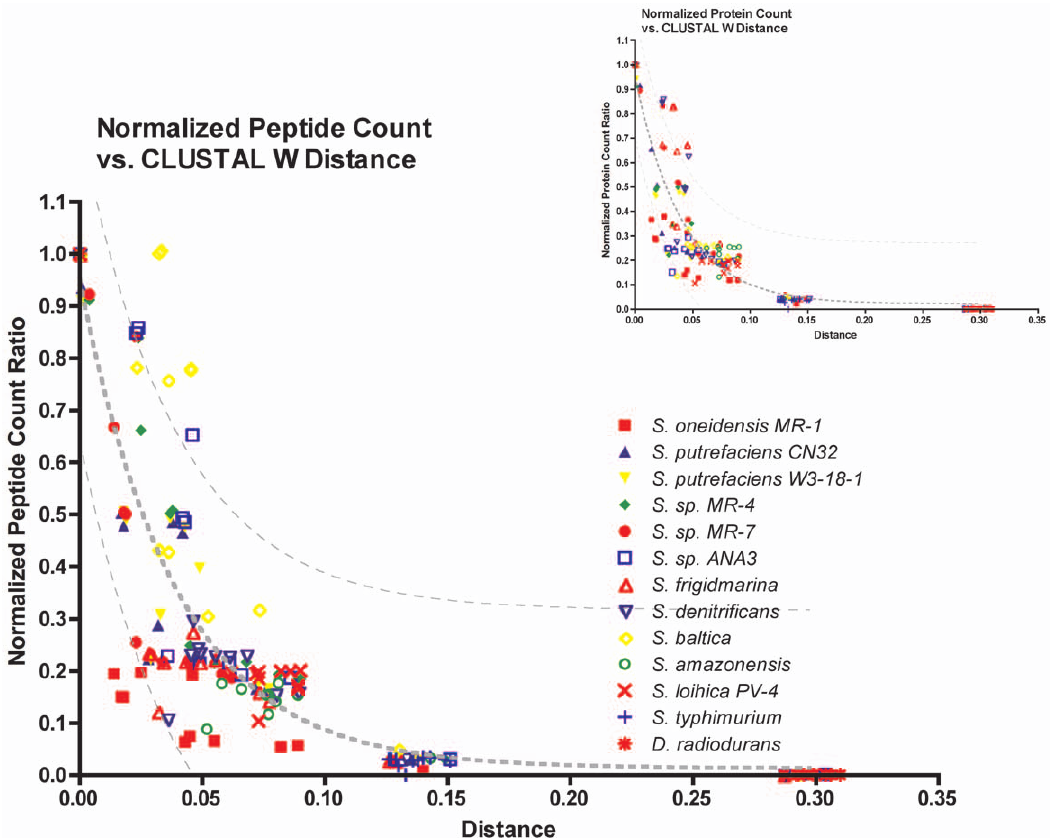
Figure 1. Peptide conservation (inset: protein conservation) was examined across the different species by graphing the normalized number of observed peptides (proteins) with respect to evolutionary distance. As the distance increases, the number of successfully identified features decreases. Data were fit to a one-phase exponential decay; 95% confidence interval for the observed features is shown with a hashed line. Each point represents the reference proteome peptide count relative to the near neighbor peptide count.